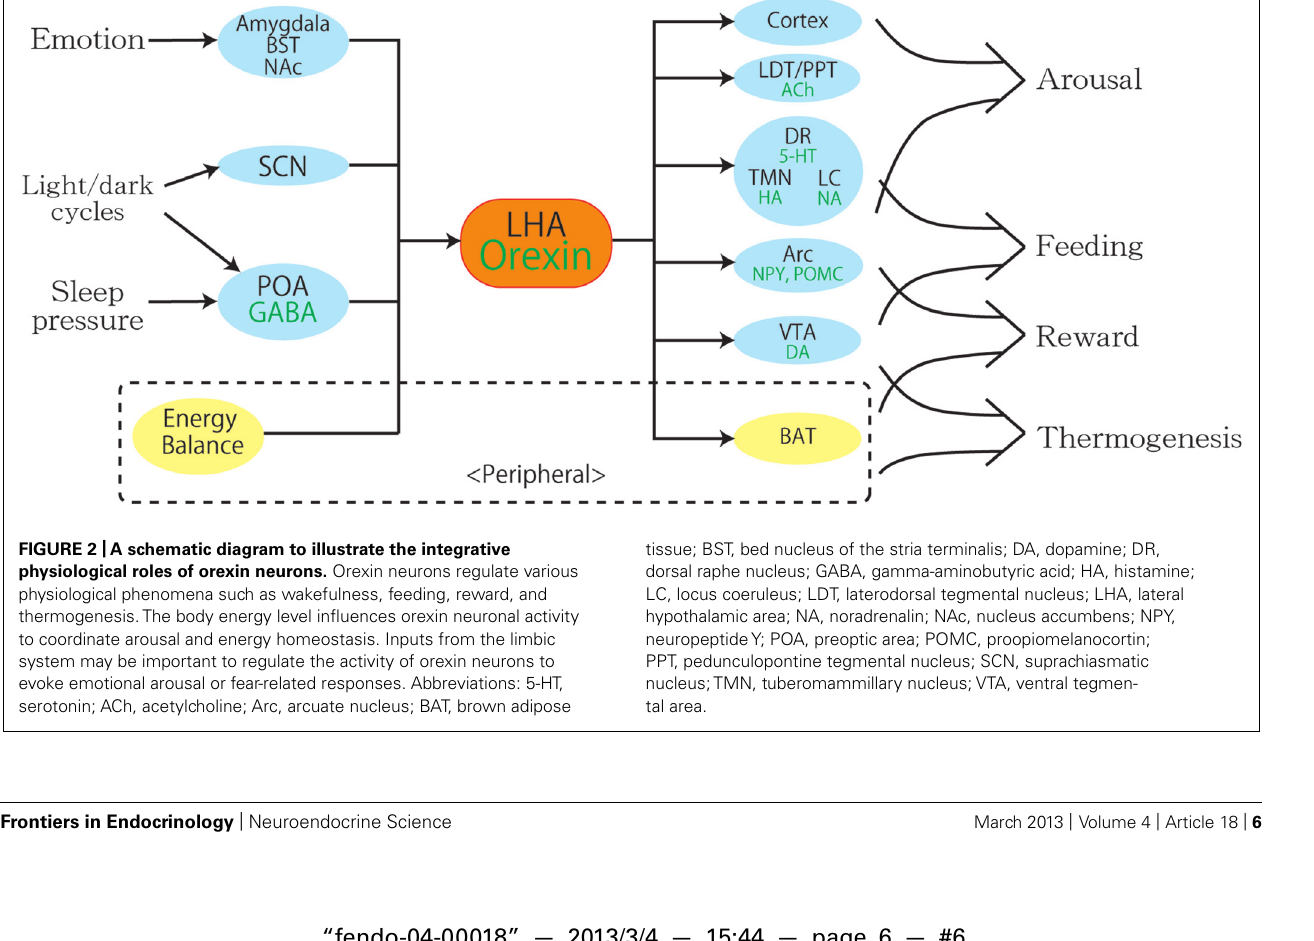
tissue; BST, bed nucleus of the stria terminalis; DA, dopamine; DR, dorsal raphe nucleus; GABA, gamma-aminobutyric acid; HA, histamine; LC, locus coeruleus; LDT, laterodorsal tegmental nucleus; LHA, lateral hypothalamic area; NA, noradrenalin; NAc, nucleus accumbens; NPY, neuropeptideY; POA, preoptic area; POMC, proopiomelanocortin; PPT, pedunculopontine tegmental nucleus; SCN, suprachiasmatic nucleus;TMN, tuberomammillary nucleus;VTA, ventral tegmen- tal